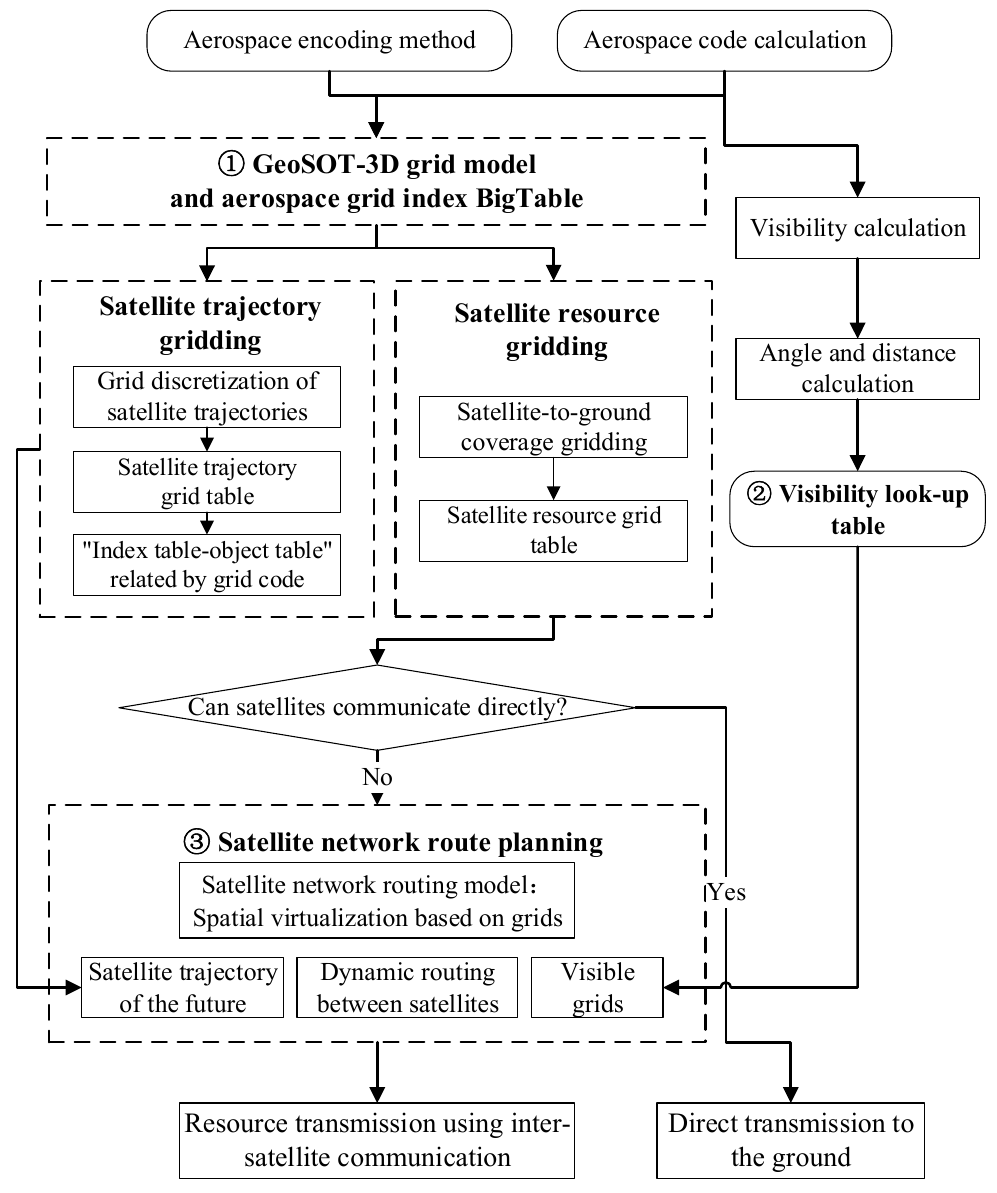
Figure 1. Research process.